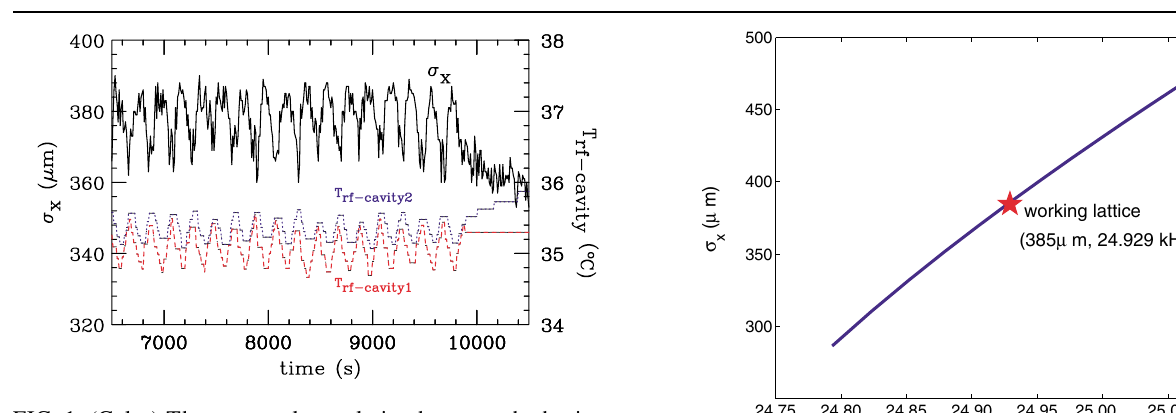
1. (Color) The temporal correlation between the horizon- tal beam size and the body temperature of rf cavities observed in the TLS storage ring. The data were recorded at a rate of 0.1 Hz. The machine operation condition is listed in Table I.